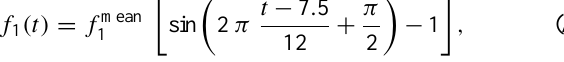
Fig. A2. Annual cycle of the radiative forcing due to ozone change of a pulse emission of NO x . The NO x emission which produces the monthly change pattern, is located at 130hPa (L11, red), 160hPa (L13, blue) and 200hPa (L15, green). Dashed lines refer to instan- taneous RF and solid ones to adjusted RF. (a) Seasonal cycle of RF. (b) as (a) , but normalised to the individual August value. (c) Rela- tive difference [%] of the adjusted RF and the scaled instantaneous RF. The scaling factor is the quotient of the respective August val- ues. The black line shows a sine fit f 1 (see Eq. (A3)).